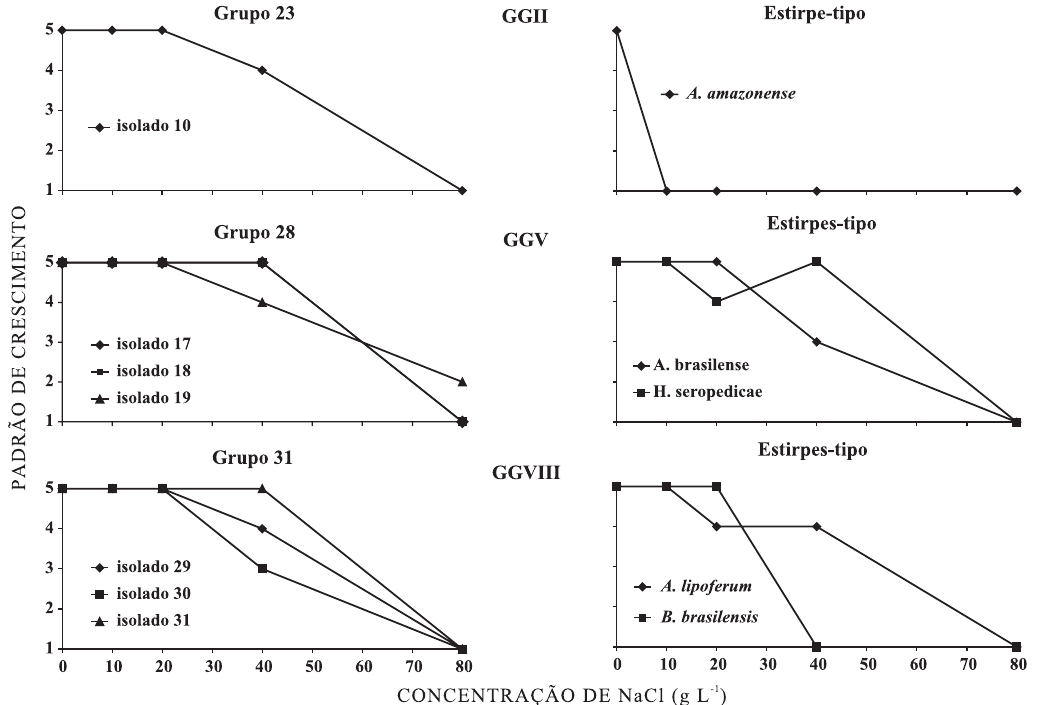
Figura 4. Teste de tolerância à salinidade dos isolados de bactérias diazotróficas não simbióticas de alguns grupos fenotípicos culturais pertencentes aos grandes grupos (GG) avaliados, referentes à coleta de setembro/2006.